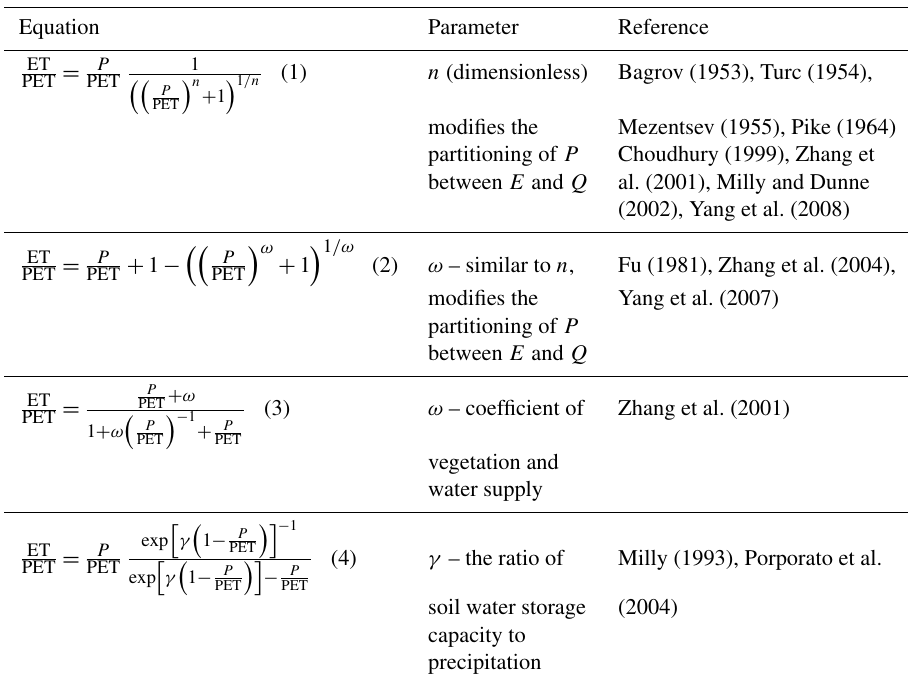
Figure 2. Budyko framework and energy and water limit lines. The blue cloud is a smoothed scatterplot of the 30arcsec resolution mean annual precipitation ( P ), evapotranspiration (ET), and potential evapotranspiration (PET) for continental Europe. ET and PET data are from MODIS (Mu et al., 2007), P data set is from WorldClim (Hijmans et al., 2005). Table 1. Alternative empirical equations for mean annual evaporation rate in Budyko framework: ET is mean annual evapotranspiration, P is mean annual precipitation, PET is mean annual potential evapotranspiration (evaporative